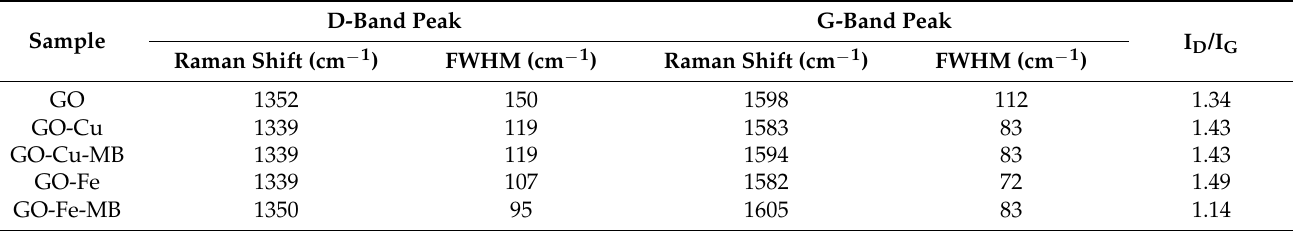
Table 1. The D and G-band positions, I D /I G ratios, and